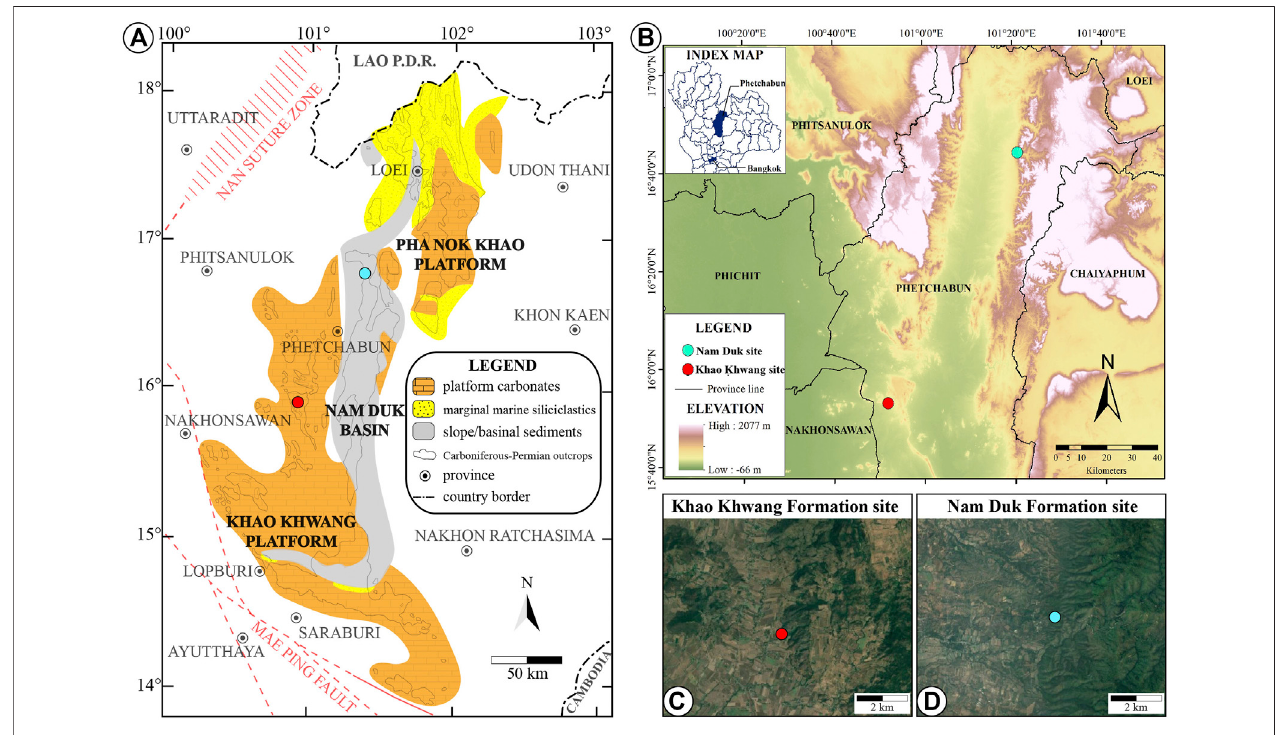
FIGURE 1 | (A) distribution of the Permian rocks, the Khao Khwang and Pha Nok Khao Platforms, separated by the Nam Duk Basin in the Loei-Phetchabun Fold Belt, central Thailand (modi fi ed from Ueno and Charoentitirat, 2011); (B) sample locations (Nam Duk and Khao Khwang sites) in Phetchabun Province, Thailand; (C) sample collection at Khao Khwang Formation; (D) sample collection at Nam Duk